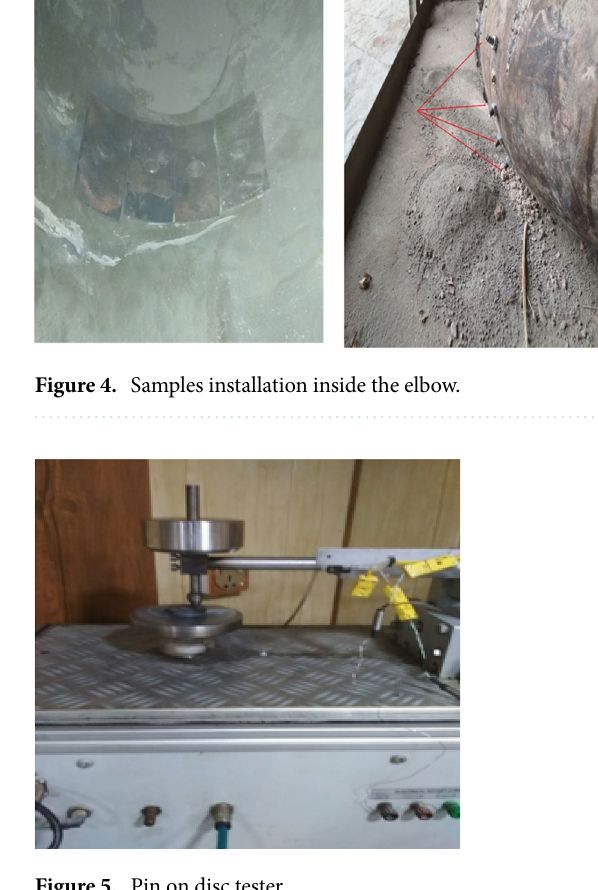
Figure 5. Pin on disc tester.